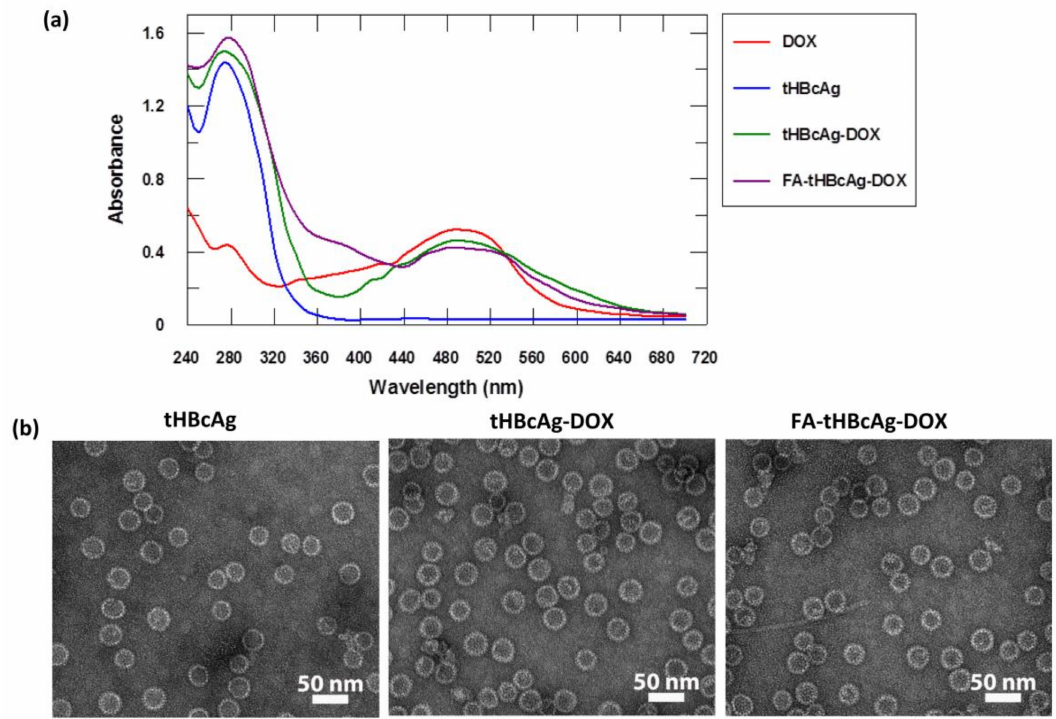
Figure 5. Conjugation of tHBcAg VLNPs with doxorubicin and folic acid. ( a ) Spectra of doxorubicin (DOX), tHBcAg VLNPs (tHBcAg), tHBcAg VLNPs conjugated with DOX (tHBcAg-DOX), and tHBcAg VLNPs conjugated with folic acid (FA) and DOX (FA-tHBcAg-DOX); ( b ) Transmission electron micrographs of tHBcAg VLNPs conjugated with DOX and FA. Nanoparticles formed by tHBcAg VLNPs (tHBcAg), tHBcAg VLNPs conjugated with DOX (tHBcAg-DOX), and tHBcAg VLNPs conjugated with DOX and FA (FA-tHBcAg-DOX). The white bars indicate 50